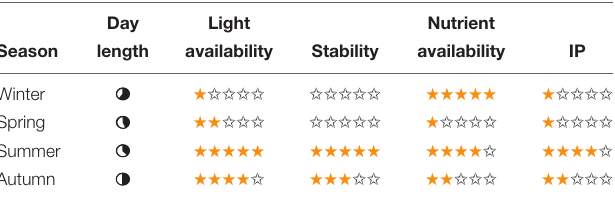
TABLE 3 | Conceptual diagram representing the seasonal variation of day length, light availability, stability, nutrients availability, and average euphotic zone integrated primary production (IP).